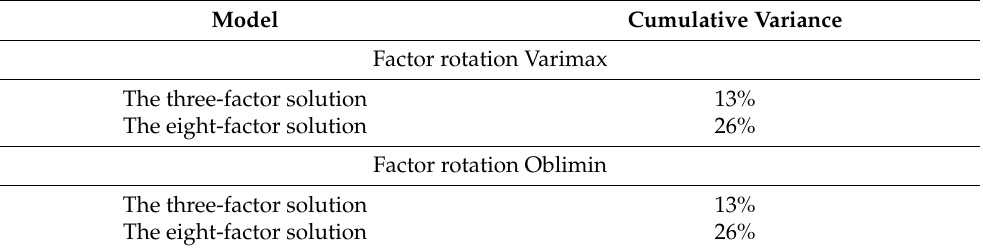
Table 6. The cumulative variance of each n-factor